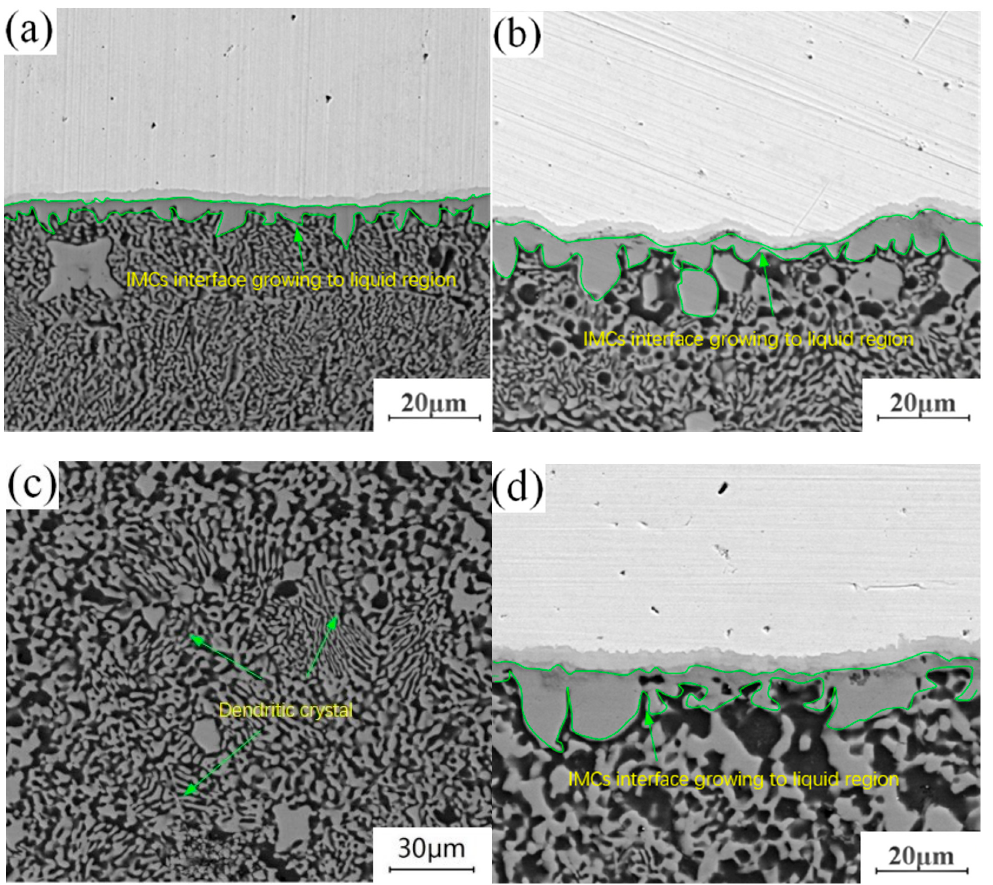
Figure 7. Structural evolution of liquid phase region: ( a ) Unannealed joint; ( b ) Annealing temperature of 300 °C and holding time of 4.5 h; ( c ) Annealing temperature of 350 °C and holding time of 4.5 h; ( d ) Annealing temperature of 400 °C and holding time of 4.5 h.